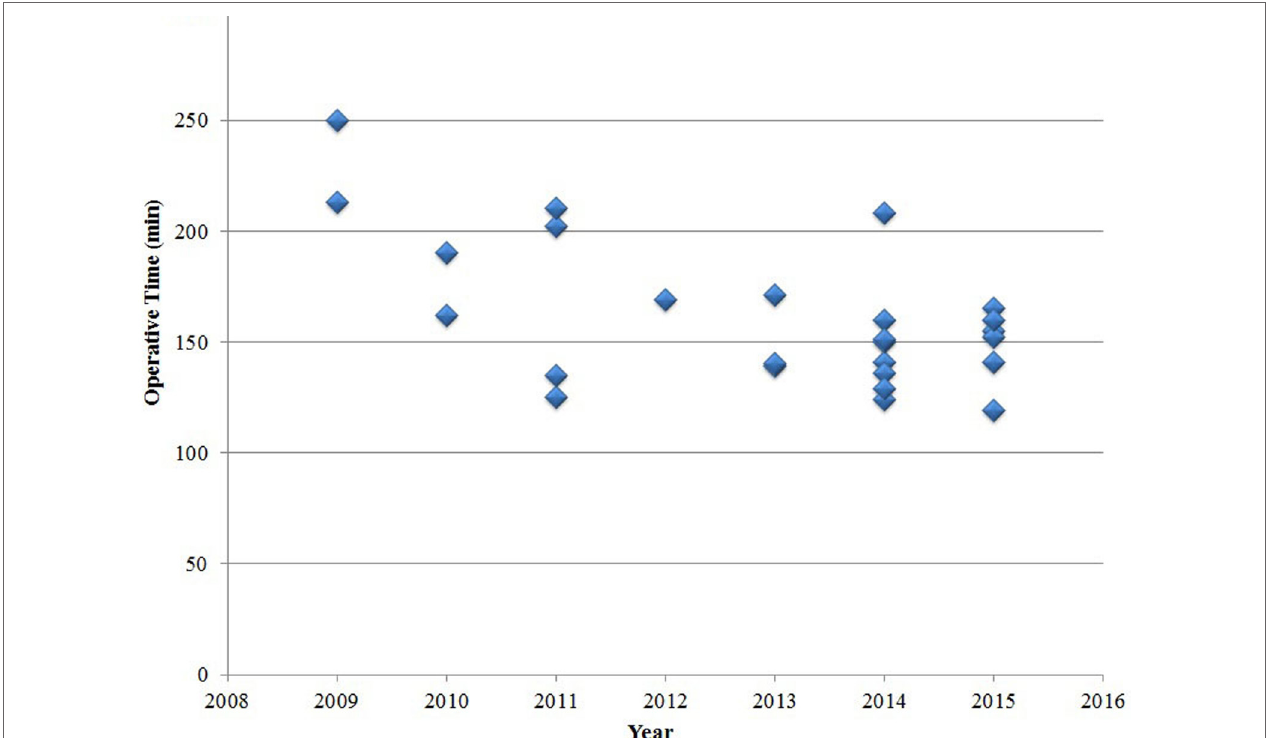
FigUre 2 | Operation time in the laparoscopic